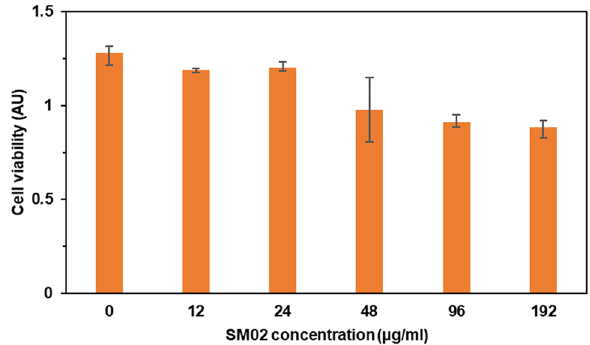
Figure 6. Cytotoxicity assay of pyrimidomycin against HuH-7 human cell line. Various concentration of pyrimidomycin was added in respective well having cells. Each concentration point was taken in triplicate.